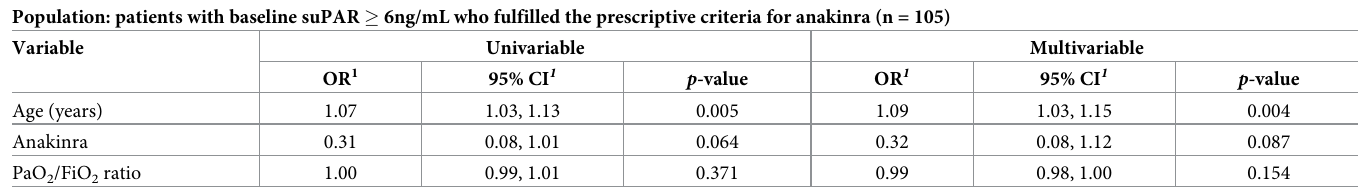
Table 3. Crude multiple logistic regression for risk factors associated with progression towards severe disease or death at day 14.